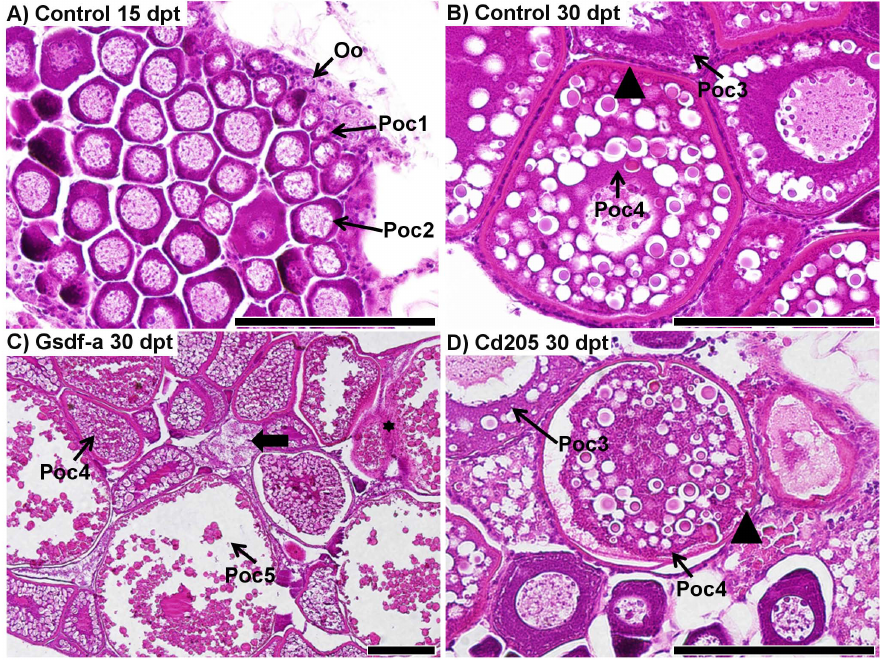
Figure 4. Histological comparison of ovary development in control and experimental fish. A) A representative ovary from a control fish (36.8 mg, 17.2 mm) at 15 days post treatment (dpt); primary oocytes at stage 2 (Poc2) are located predominantly in the center, whereas primary oocytes at stage 1 (Poc1) and oogonia (Oo) are located in the periphery of the ovary. B) A representative ovary from a control fish (216.0 mg, 29.9 mm) at 30 dpt; stage 4 vitellogenic primary oocytes (Poc4) have a thick zona radiata (arrowhead) surrounded by an even layer of follicular cells. Stage 3 previtellogenic primary oocytes lack the thick zona radiata . C) Ovary from an anti-Gsdf-a treated fish at 30 dpt (326.3 mg, 31.9 mm): stage 4 and 5 (Poc5) primary oocytes weredeveloped. An atretic oocyte is identified by the thick arrow. Granulomatous inflammatory reaction as a consequence of invasion of peritonial cells is identified by the black star. D) Ovary from an anti-Cd205 treated fish at 30 dpt (241.0 mg, 30.5 mm): zona radiata is apparently thinner than in controls, and some invaginations are evident (arrowhead), indicating the onset of the atresia process. An irregular follicular layer also indicates atresia (thick arrow). Scalebars represent 100 m